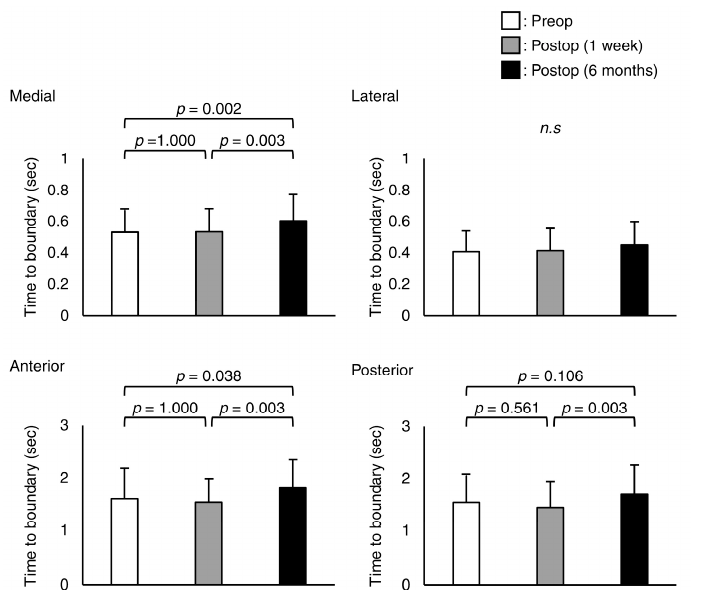
Figure 3. Mean and standard deviation values of the absolute minimum of the time-to-boundary in medial, lateral, anterior, and posterior directions. N.S means not significant. There were significant differences in the mean minimum TTB in the medial, lateral, anterior, and posterior directions ( p = 0.004, p = 0.043, p = 0.005, and p = 0.001, respectively) (Figure 4). The mean minimum TTB for the medial, lateral, and anterior directions at 6 months post-operation was higher than the preoperative and 1 week post-surgery values ( p = 0.013, p = 0.034, p = 0.008, p = 0.007, p = 0.001, and p = 0.005, respectively). The mean minimum posterior TTB at 6 months post-operation was higher than that at 1 week post- operation trials ( p < 0.001).